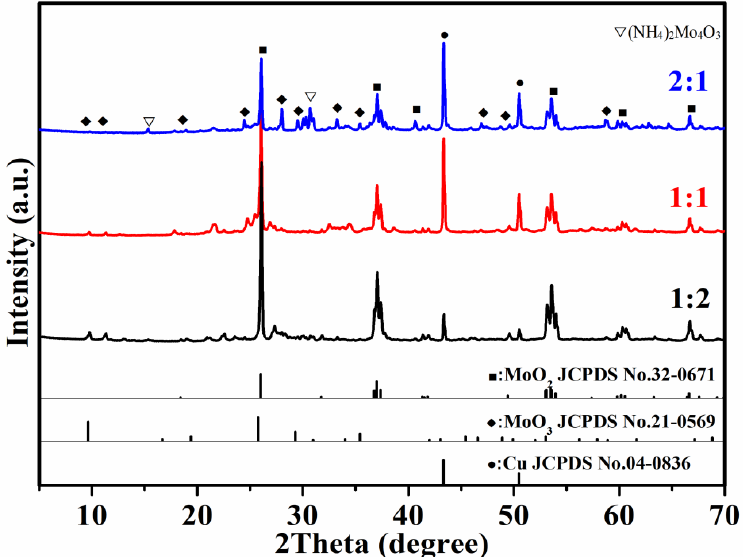
Figure 1. XRD patterns of Cu/MoO x samples pre-reduced at 450 °C for 2 h. Typical SEM micrographs of Cu/MoO x samples with different atomic ratios of Cu/Mo are shown in Figure 2. The SEM images clearly show the difference in the microstructure of the Cu/MoO x powder with different atomic ratios. The Cu/MoO x powders with a Cu/Mo ratio of 1:1 (Figure 2b,e) show micro/nano structures formed by loose sheets and particles. The particle size distribution is from 0.2 μ m to 2.5 μ m with many holes and caves. This micro/nano porous structure provides a larger specific surface area and more active sites, which is beneficial for the transportation of reactants and products in the re- action process. When Cu/Mo ratios are 1:2 and 2:1, the two samples appear to be com- posed of more widely distributed and irregular particles with smooth surfaces, as shown in Figure 2a,d,c,f.